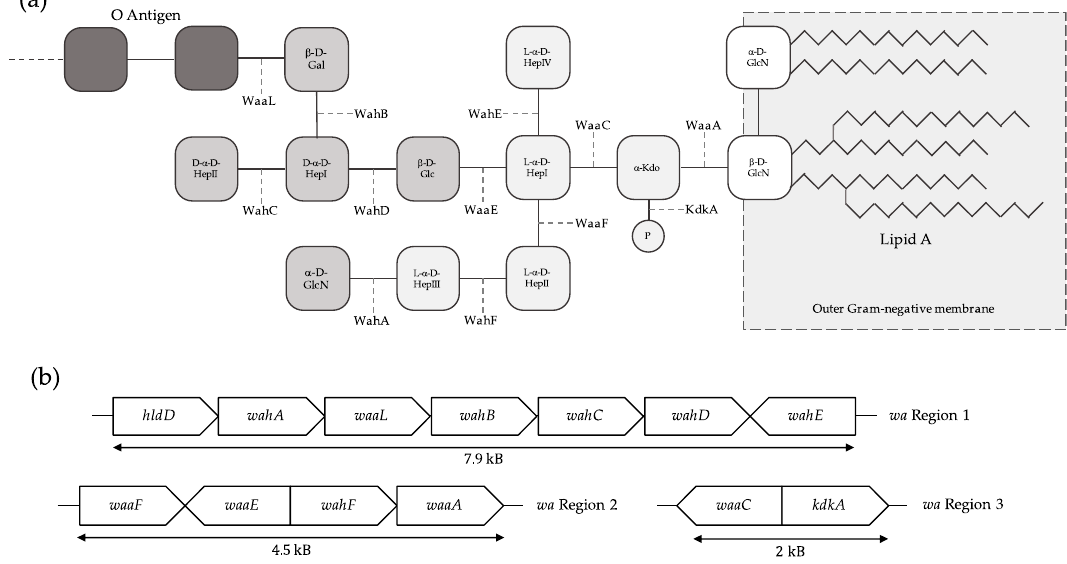
Figure 1. Structure and genomic organization of the Aeromonas piscicola AH-3 lipopolysaccharide (LPS). ( a ) Chemical structure of the A . piscicola AH-3 LPS. From clearer to darker, the carbohydrates of the inner core oligosaccharide, outer core oligosaccharide, and O-antigen (only the first two molecules) are shown. The name of the proteins catalysing each reaction is shown in each link between components; and ( b ) Genomic organization of the A . piscicola AH-3 genes coding for the proteins taking part in the LPS biosynthesis.